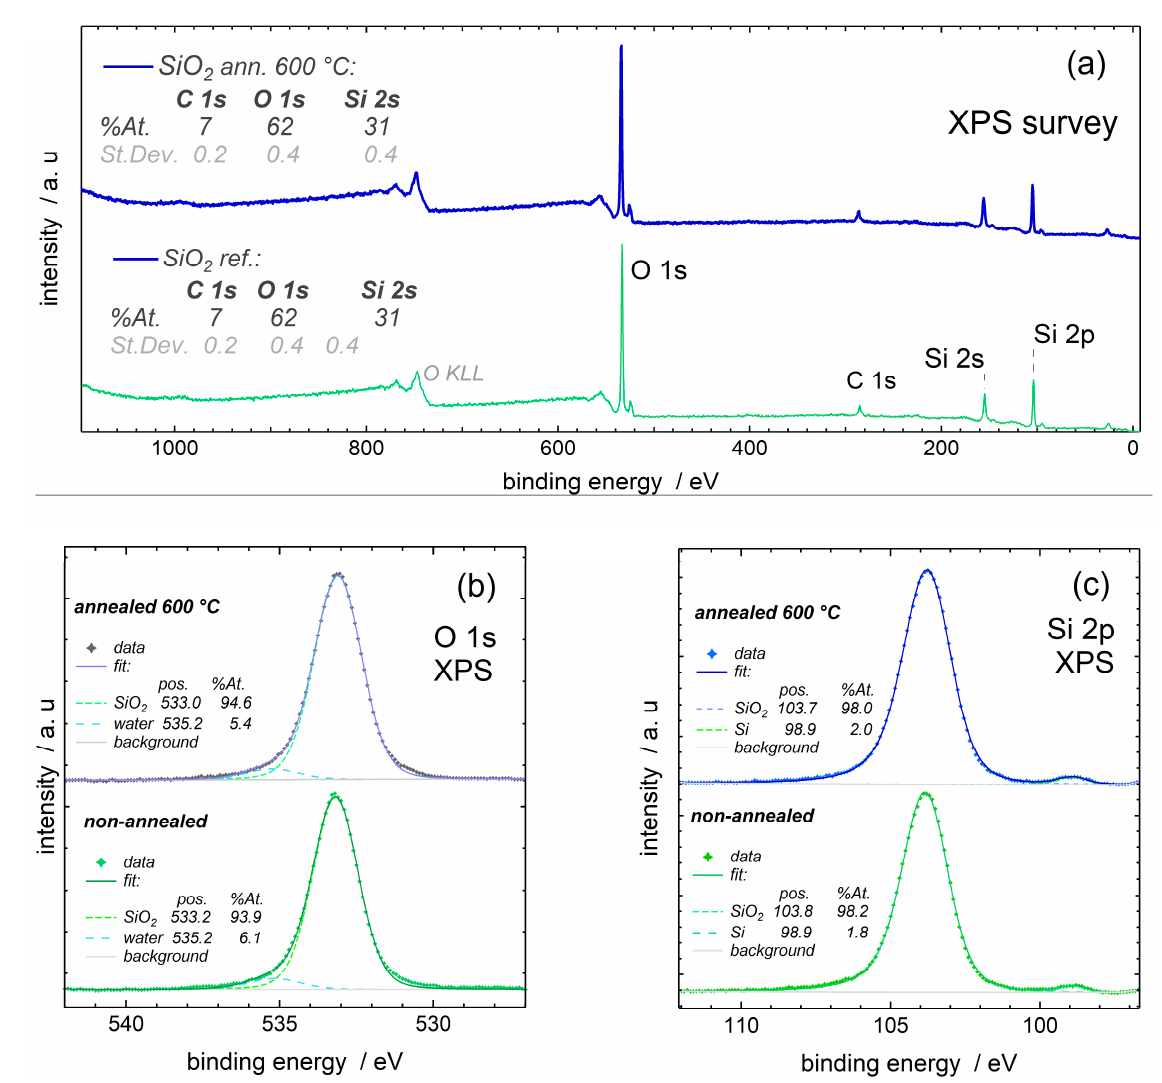
Figure 5. The survey ( a ) and elemental ( b , c ) XPS scans from the surfaces of non-annealed (as- deposited) and annealed SiO 2 thin films. Positions of bands characteristic of oxygen ( b ) and silicon- containing compounds or elemental Si ( c ) are denoted by